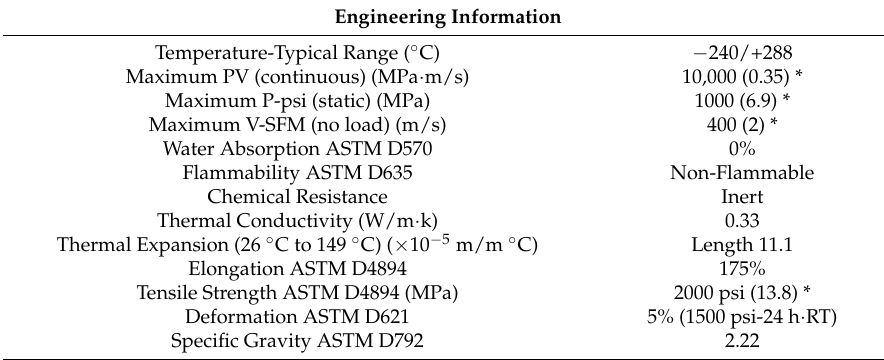
Table 1. The engineering information and physical data of the glass fiber-reinforced Polytetrafluoroethylene (GFRPTFE)